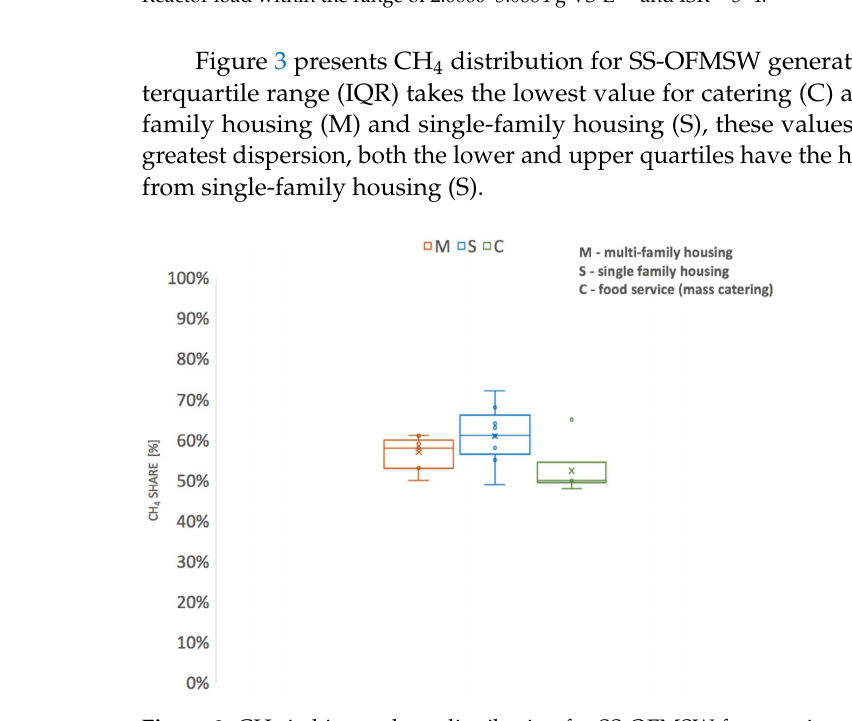
Figure 3. CH 4 in biogas share distribution for SS-OFMSW from various sources (M, S,